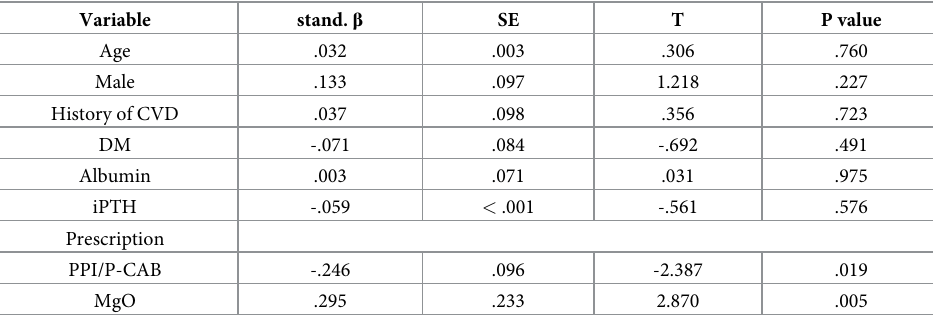
Table 4. Multiple linear regression for serum Mg levels.